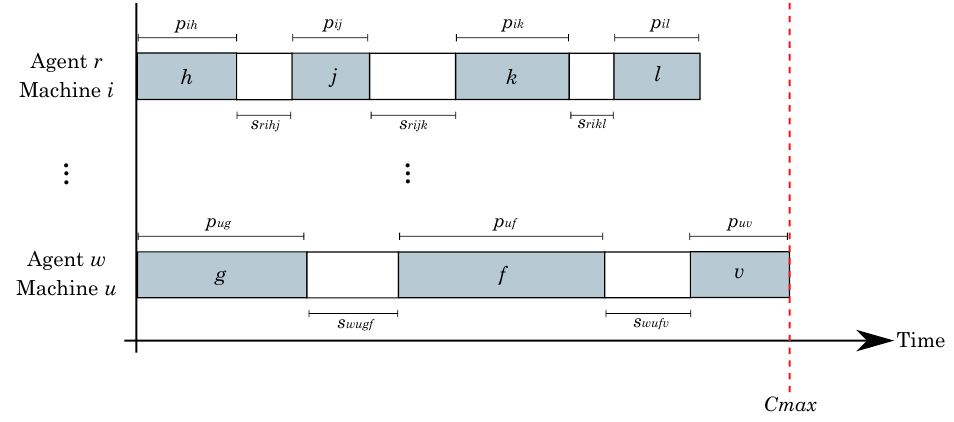
Figure 1. Graphical representation of the